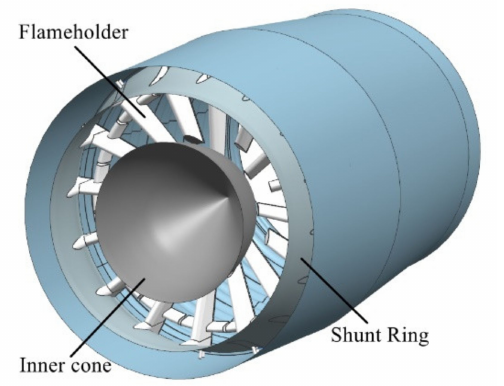
Figure 1. Schematic diagram of integrated afterburner.